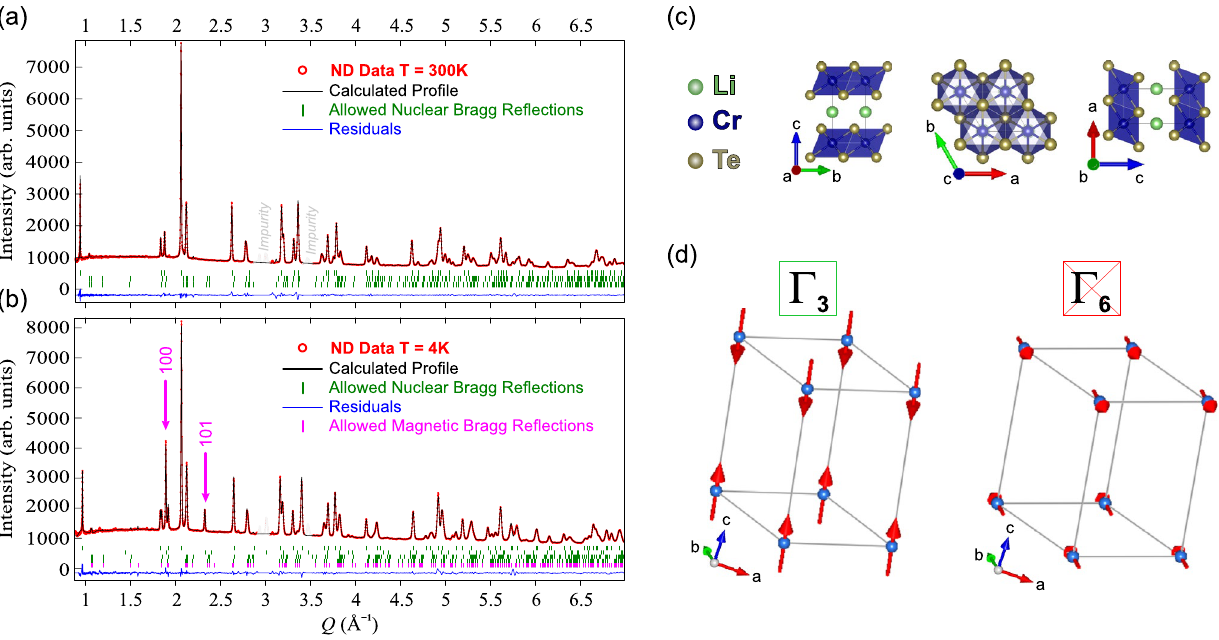
Figure 4. Neutron diffraction pattern with the corresponding calculated pattern resulting from magnetic 300 K and ( b ) T 4 K. The magenta arrows on the low temperature plot and structural refinement at ( a ) T = = 1 1 highlights the position of the magnetic peaks. The dotted areas in the pattern around 3 Å − and 3.5 Å − are regions in which unknown impurity reflections are located. These regions were excluded from the refinement. ( c ) Graphic representation of the low temperature crystal structure of LiCrTe 2 oriented along the main axes of the unit cell. ( d ) Graphic representation of the two possible antiferromagnetic spin structures in LiCrTe 2 . The red arrows represent the ordered Cr moments. Here Ŵ 3 clearly gives a much better agreement than Ŵ 6 . See also Table 2 for more details.